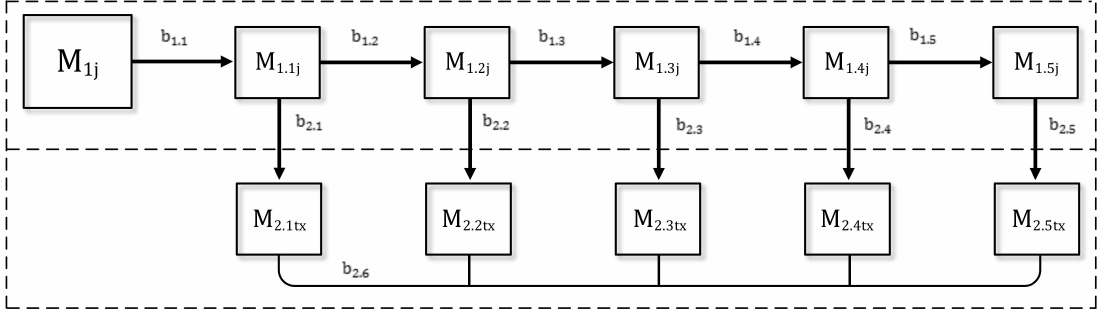
Figure 5. Formal model of cyberattack impact threats.